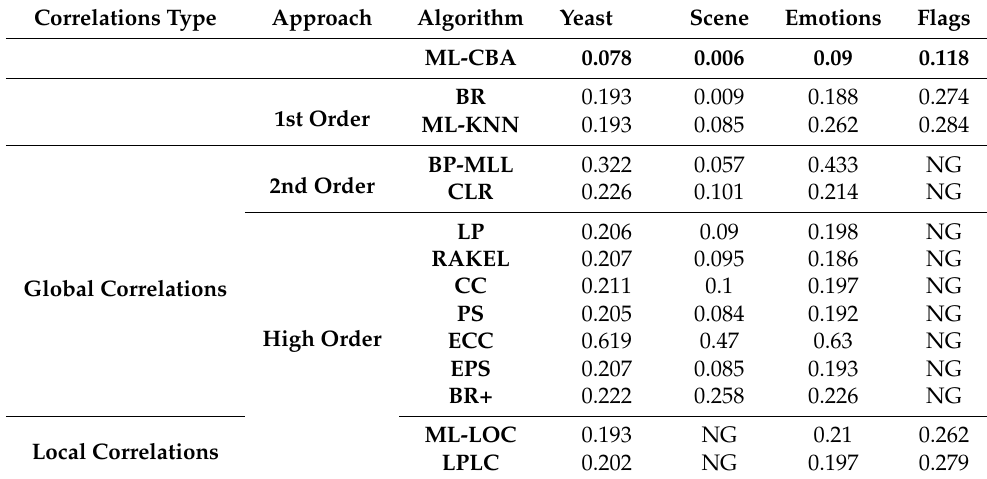
Table 3. Evaluation of the proposed ML-CBA algorithm on the regular-sized datasets using Hamming loss metric, with respect to different MLC